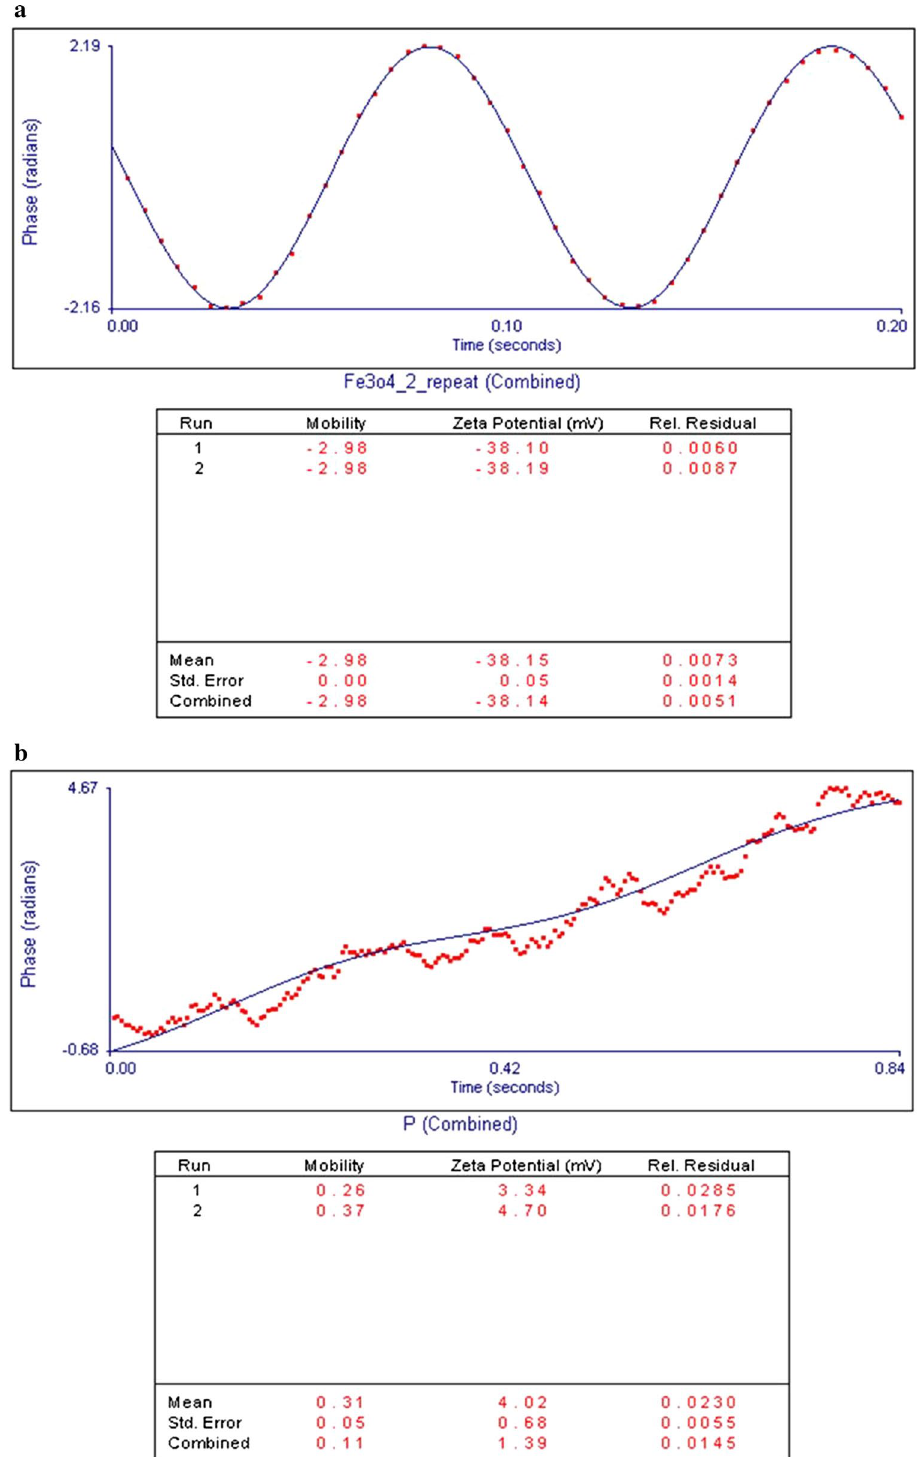
Fig. 6 Zeta potential analysis of a SPIONs, b chitosan-coated